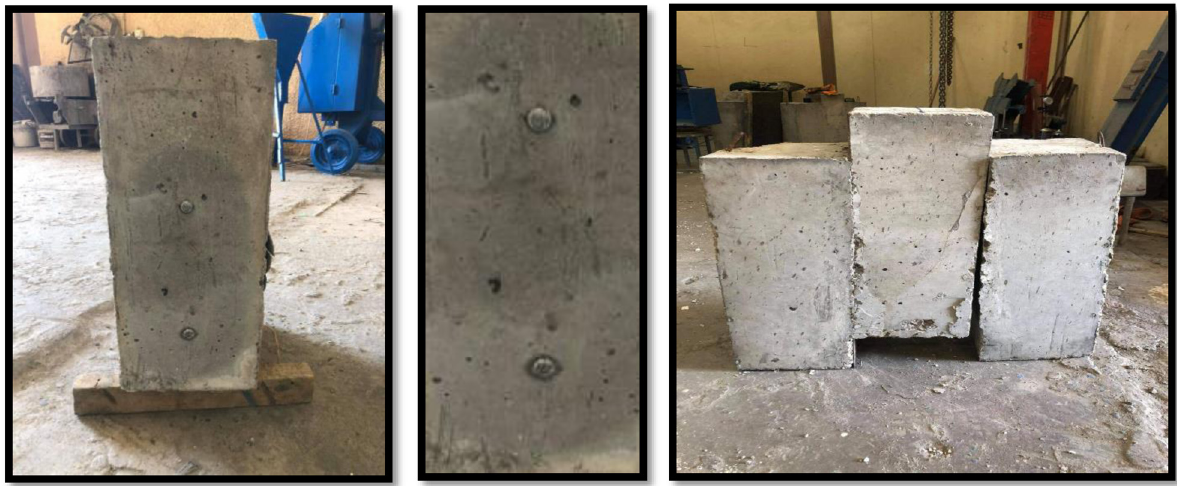
Figure 4: Failure mode of specimens.